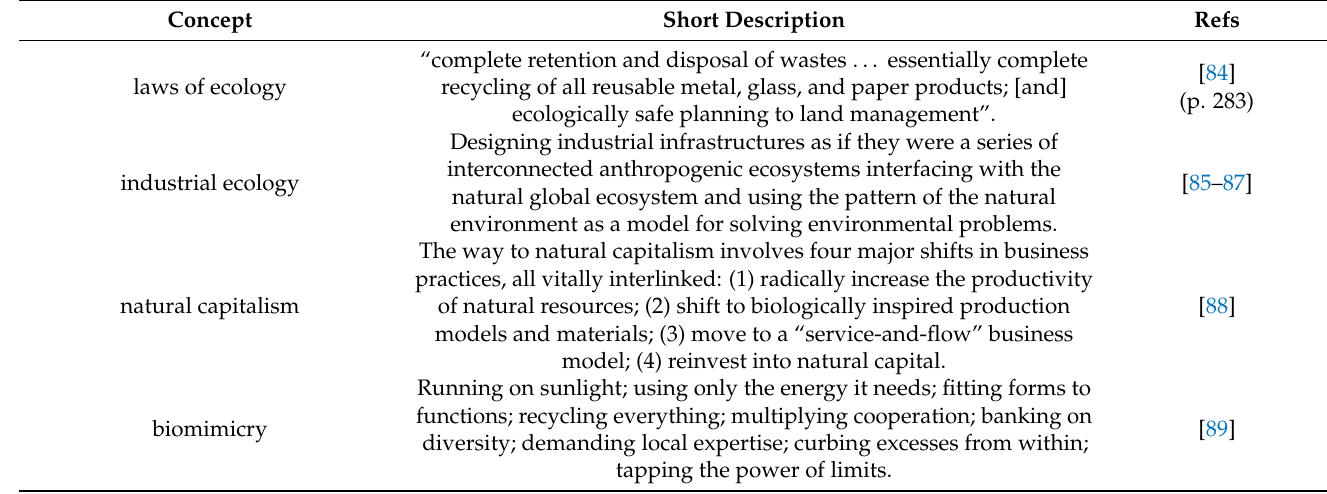
Table 4. Different approaches to understanding the concept of circular economy. Concept Short Description